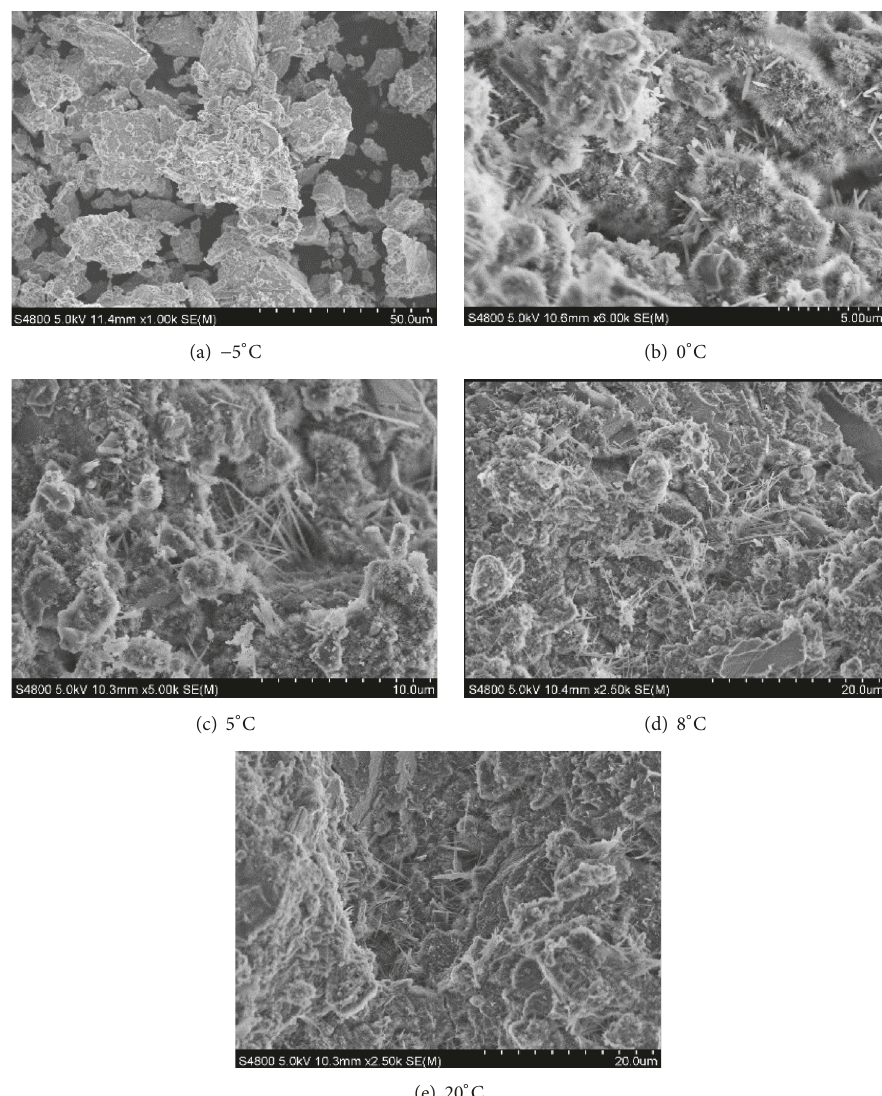
Figure 8: SEM images of solid cement pastes cured under low temperatures